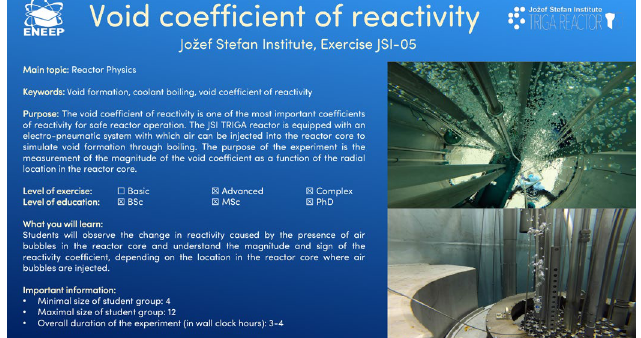
Fig. 6. Example of experiment presentation materials – JSI, Measurement of the void coefficient of reactivity.